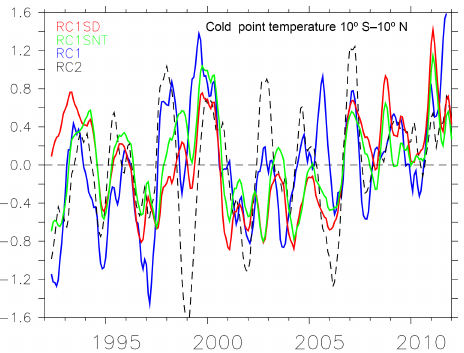
Figure 5. Cold point temperature anomalies (K; deseasonalized, 12- month running mean) derived from RC1SD, RC1SDNT, RC1, and RC2 simulations.